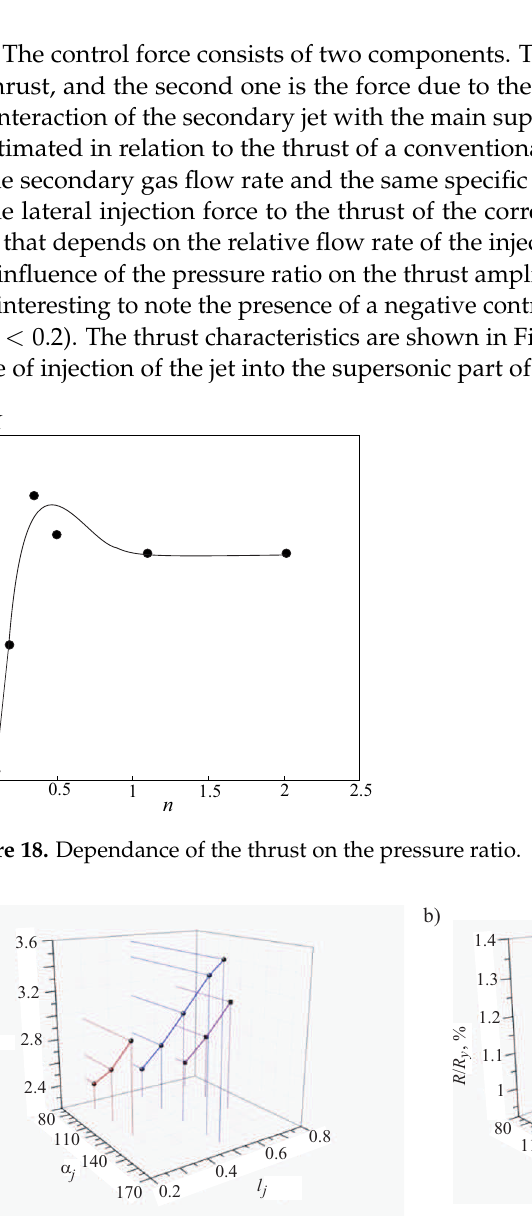
Figure 19. Dependance of the thrust coefficient ( a ) and thrust ( b ) on the angle and location of jet